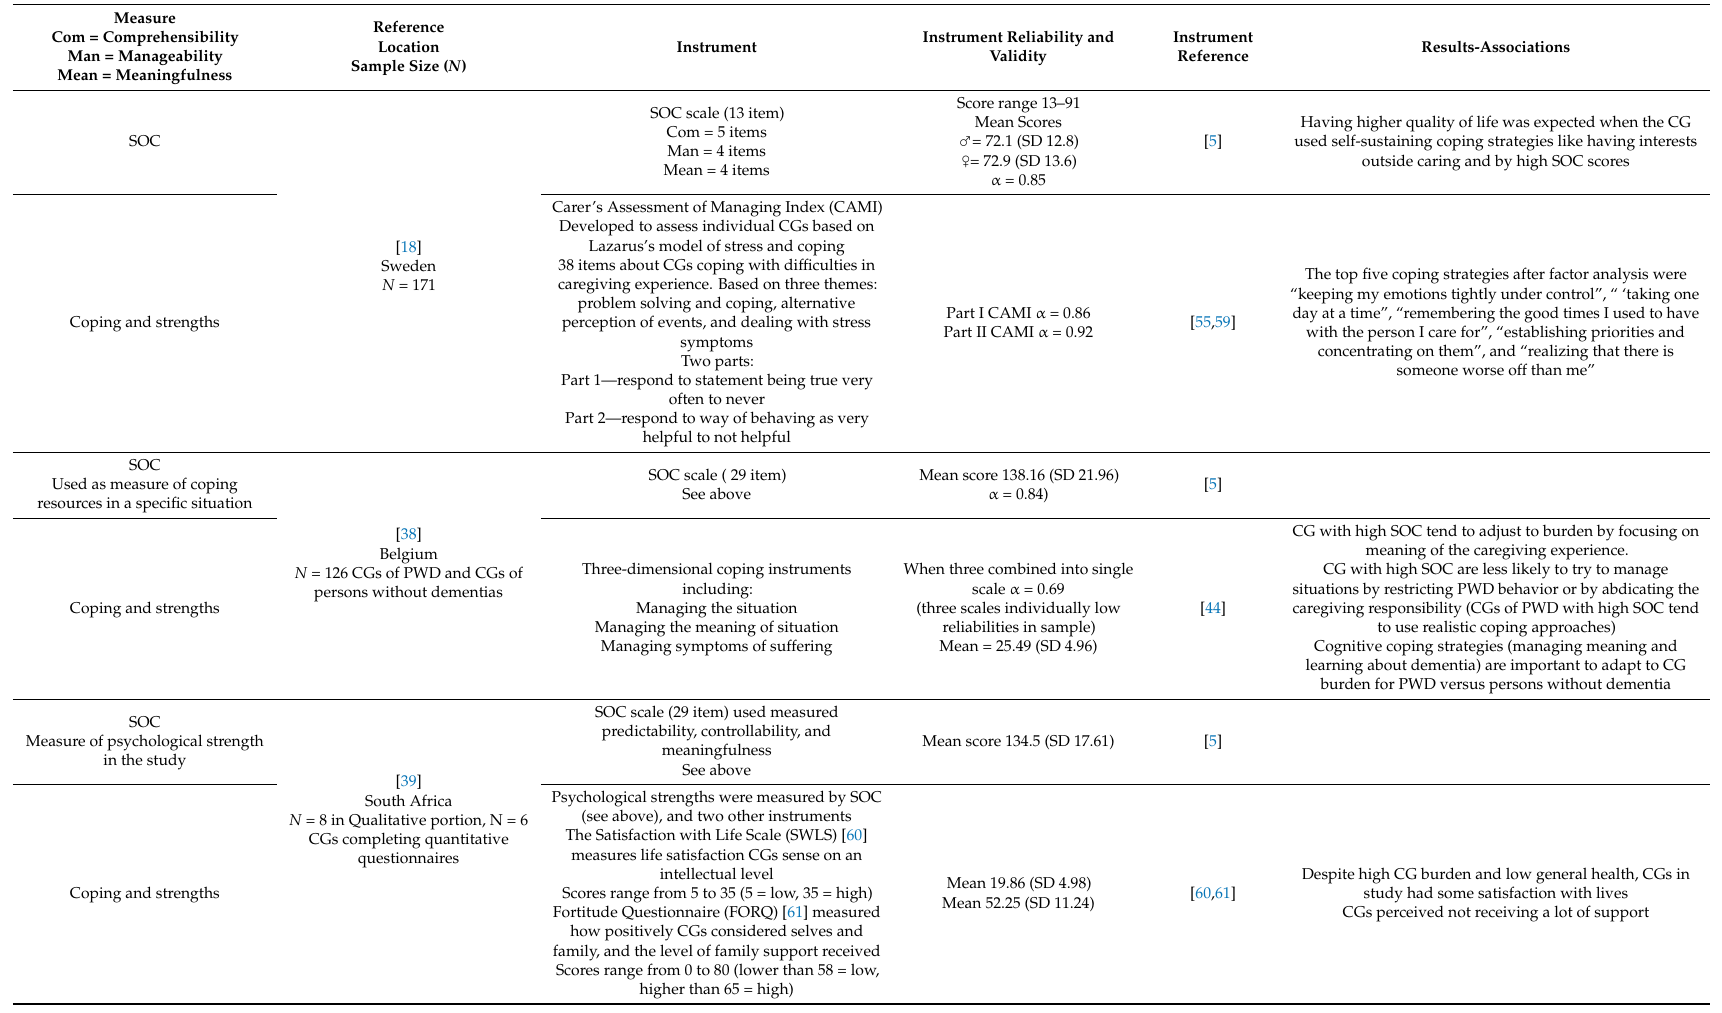
Table 3. Sense of Coherence (SOC) and coping as strengths. CG: Caregiver; PWD: Person with